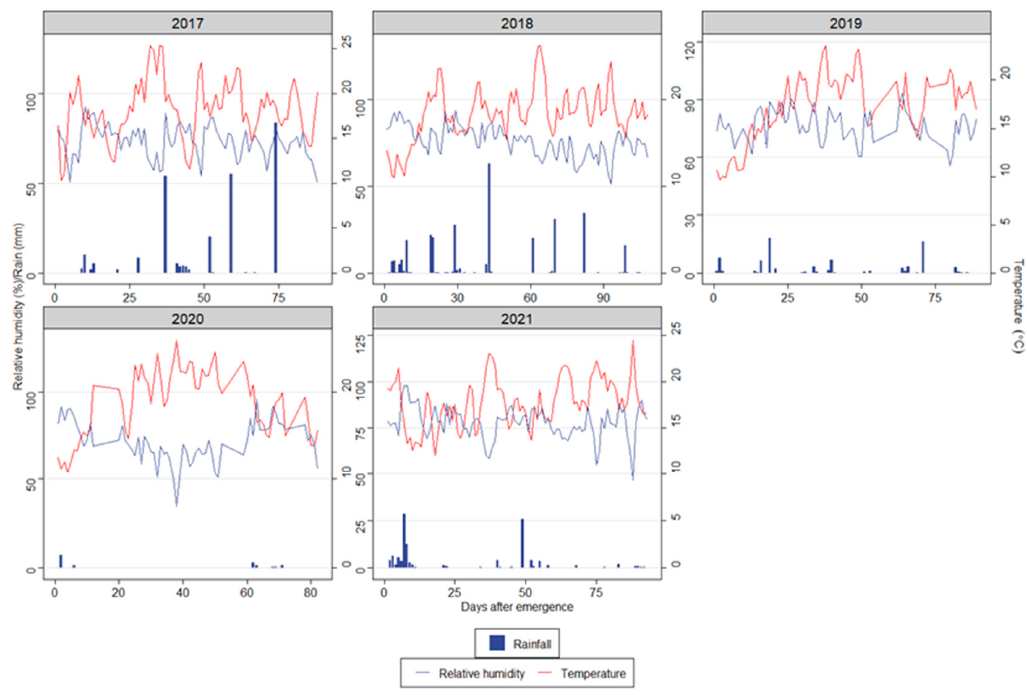
Figure 1. The weather conditions during the cropping seasons (2017–2021). The variables of daily mean relative humidity (RH, %) and accumulated rain (mm) are represented in Y1, and daily mean temperature (%) is shown in Y2. Days after emergence were the number of days after 50% of emergence. The emergence dates were 16 May (2017), 1 June (2018), 4 June (2019), and 10 June (2020 and 2021) (Table S1).